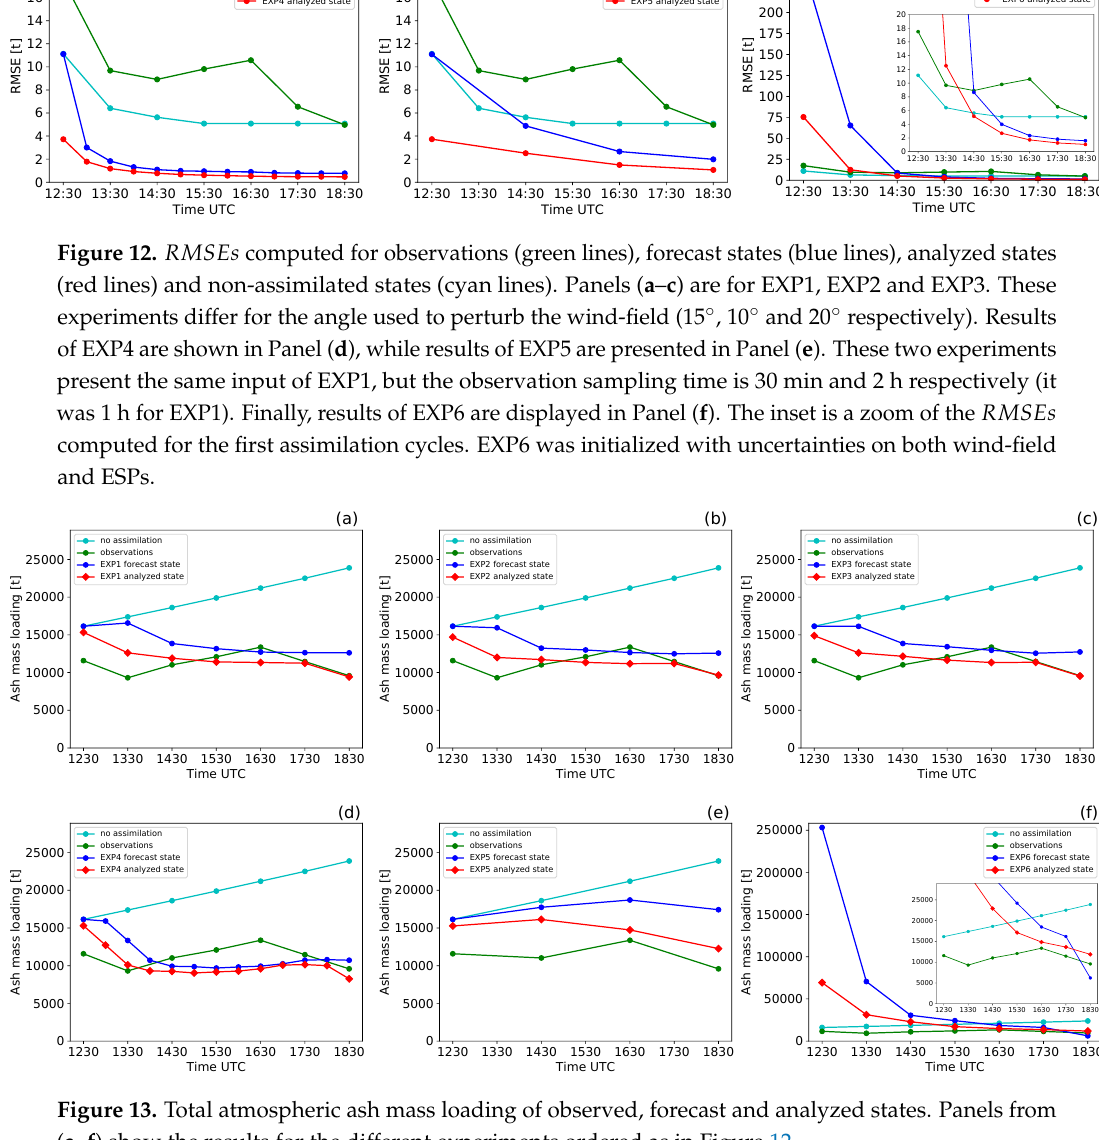
Figure 13. Total atmospheric ash mass loading of observed, forecast and analyzed states. Panels from ( a – f ) show the results for the different experiments ordered as in Figure